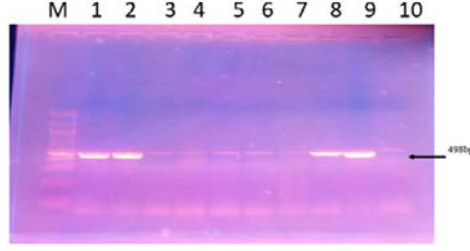
Fig. 2. Detection of cnf1 gene by PCR. Lane M: DNA ladder (100 bp); Lane 1: positive control (498 bp); Lanes (3&4&5&6&7 and 10) Negative. Lanes (2,8 and 9): Positive isolates.